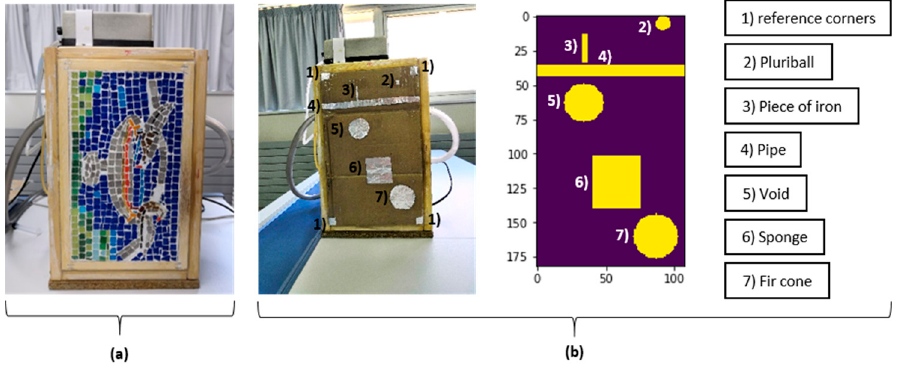
Figure 1. ( a ) Mosaic to be tested, seen from its front surface; ( b ) Frontal representation of the situation of each of the artificial internal